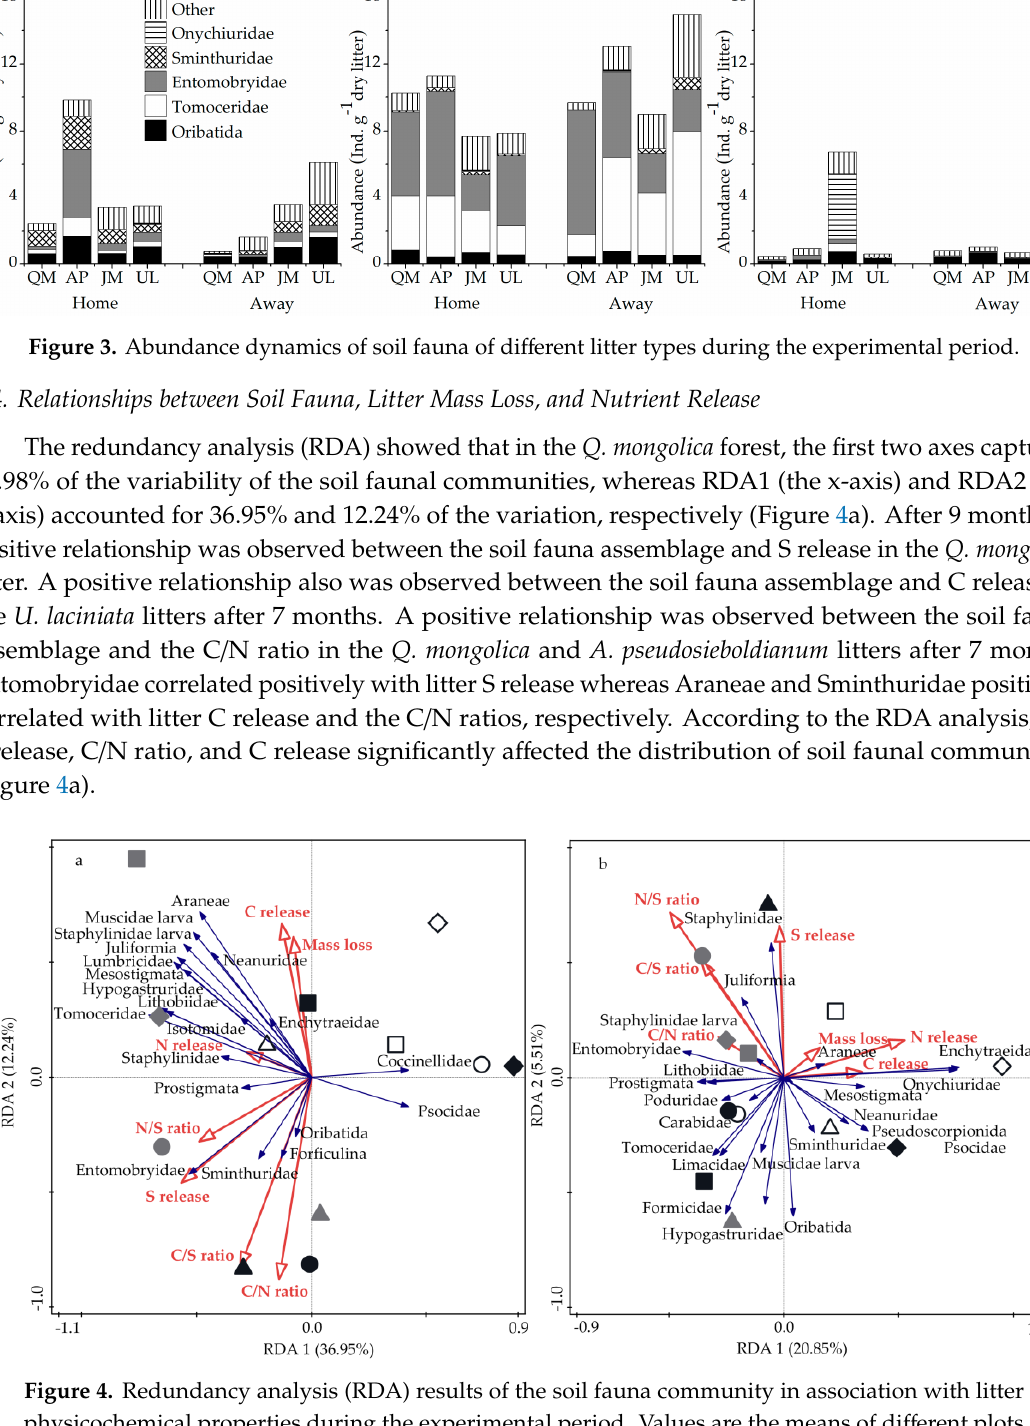
Figure 3. Abundance dynamics of soil fauna of different litter types during the experimental period.